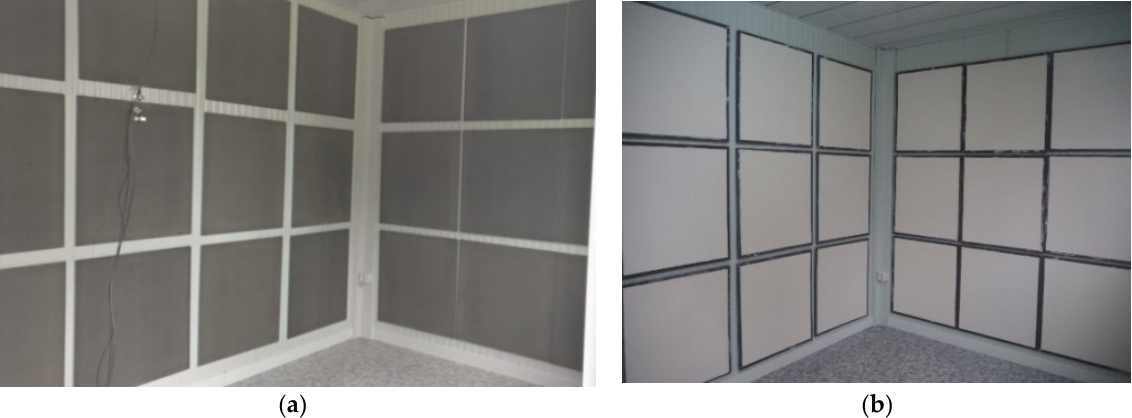
Figure 2. Indoor view of the test cells with the thermal insulation panels (WEDI ® ): ( a ) DEMO1: without PCM; ( b ) DEMO2: with PCM.